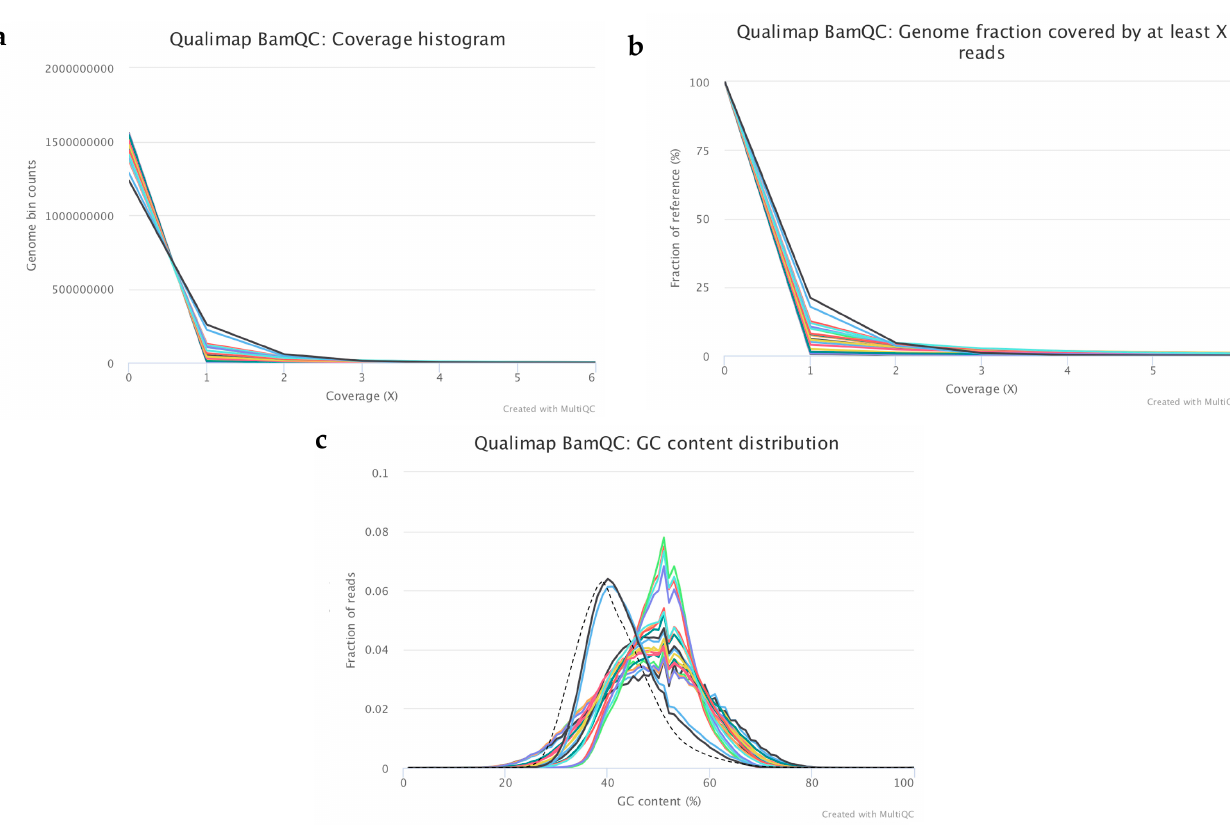
Figure 2. Representing plots from the analysis of mapping quality metrics of the selected samples. The subfigures represent the following results: ( a ) Coverage histogram showing the genomics bin counts with the corresponding coverage, ( b ) Cumulative coverage genome fractions showing the fraction (%) of the genome which has at least “X” coverage, ( c ) GC content distribution of the mapped reads where the dashed lines corresponds to the theoretical distribution. Table 1. Mapping quality metrics of the selected control media samples (c.), culture media droplets from embryos of miscarriage (0), culture media droplets of healthy neonates (1), cord blood sample with known CNVs (2).